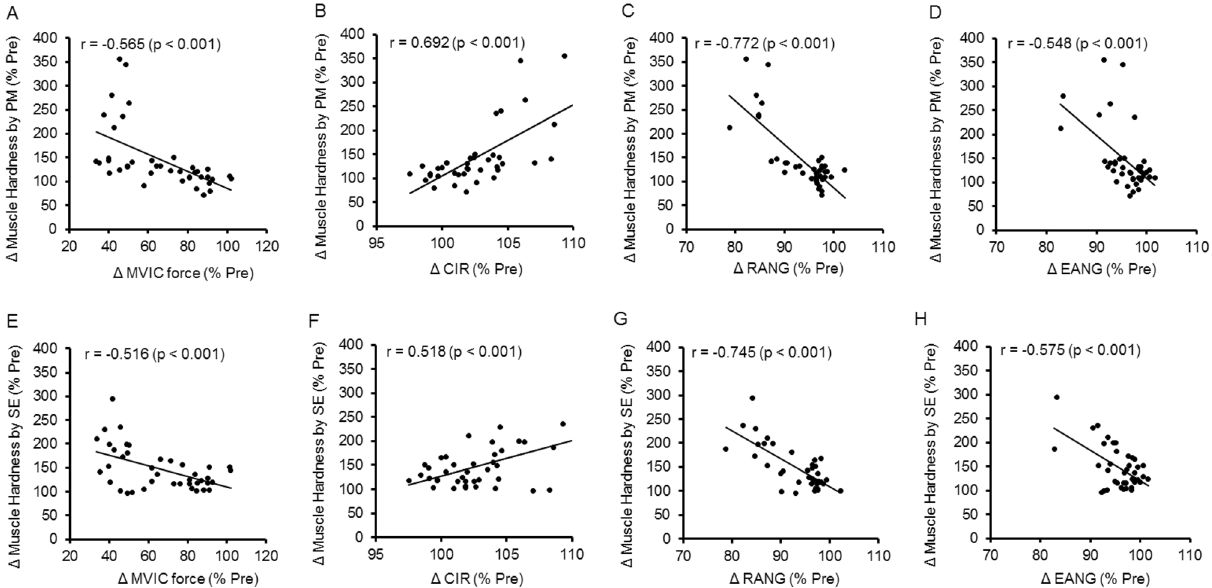
Figure 8. Relationship between muscle damage variables (maximal voluntary isometric contraction (MVIC) force, circumference (CIR), relaxed elbow angle (RANG) and extended elbow angle (EANG)) and muscle hardness assessed by push-in meter (PM) and strain elastography (SE). A significant (p < 0.001) correlation was evident between MVIC and PM (r = − 0.565, A ), MVIC and SE (r = − 0.516, E ), CIR and PM (r = 0.692, B ), CIR and SE (r = 0.518, F ), RANG and PM (r = − 0.772, C ), RANG and SE (r = − 0.745, G ), EANG and PM (r = − 0.548, D ) and EANG and SE (r = − 0.575, H Fig. 8D, respectively) and by SE (r = − 0.516: Fig. 8E and r = − 0.575: Fig. 8H, respectively). CIR also showed a significant correlation with muscle hardness assessed by PM (r = 0.692, strong: Fig. 8B) and by SE (r = 0.518,